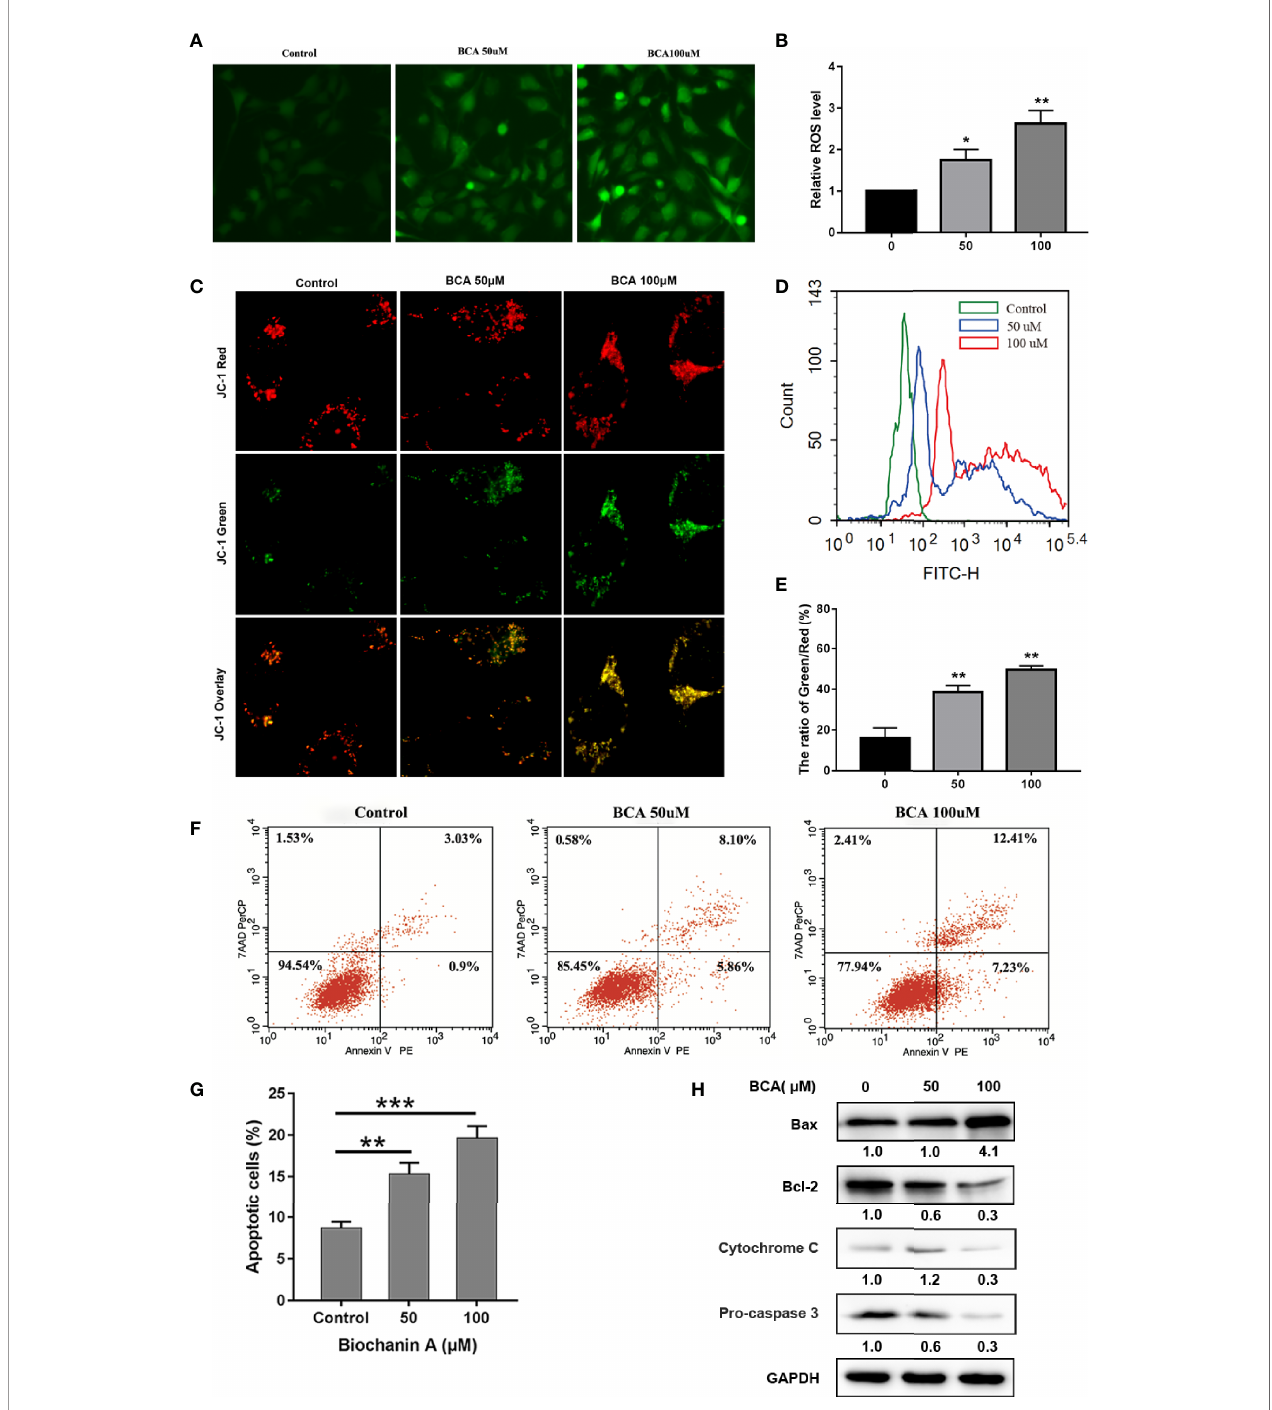
FIGURE 2 | BCA induces apoptosis of U251 by increasing ROS levels and decreasing the mitochondrial membrane potential. (A) U251 was incubated with 0, 50 and 100 m M BCA for 48 h, The ROS level were observed under a fl uorescence microscope after DCF-DA staining; (B) Quanti fi cation of relative fl uorescence intensity in A; (C) U251 cells were incubated with 0, 50 and 100 m M BCA for 48 h, mitochondrial membrane potential was observed after JC-1 staining. (D) U251 cells were incubated with 0, 50 and 100 m M BCA for 48 h, then subjected to fl ow cytometric analysis of ROS levels after DCF-DA staining; (F) Quanti fi cation of the green and red fl uorescence intensity rate in C. (F) The level of cell apoptosis was detected by fl ow cytometry. (G) The percentage of cell apoptosis ratio in A. (H) Expression levels of apoptotic related proteins (Bax, Bcl-2, cytochrome c, pro-caspase 3) at different concentrations of BCA. Data are expressed as mean ± SD. *P < 0.05, **P < 0.01, ***p < 0.001. versus